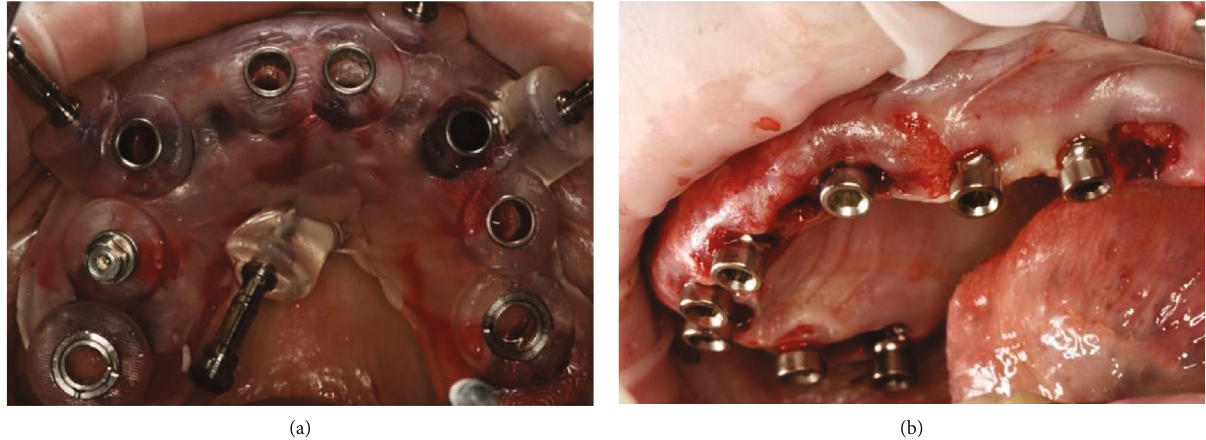
Figure 4: Full-guided surgical template attaching to the upper jaw (a). The condition of the jaw after placement of 8 dental implants by using fl apless method with installed implant drivers (b).